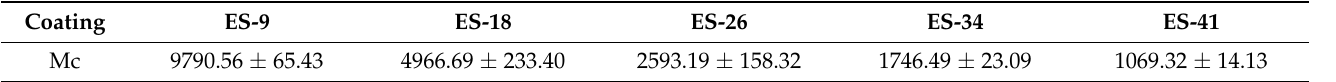
Figure 5. DSC curves of modified silicone tie-coatings. ( a ) measured, ( b ) part of measured. Table 2. Crosslink density of modified silicone tie-coatings.